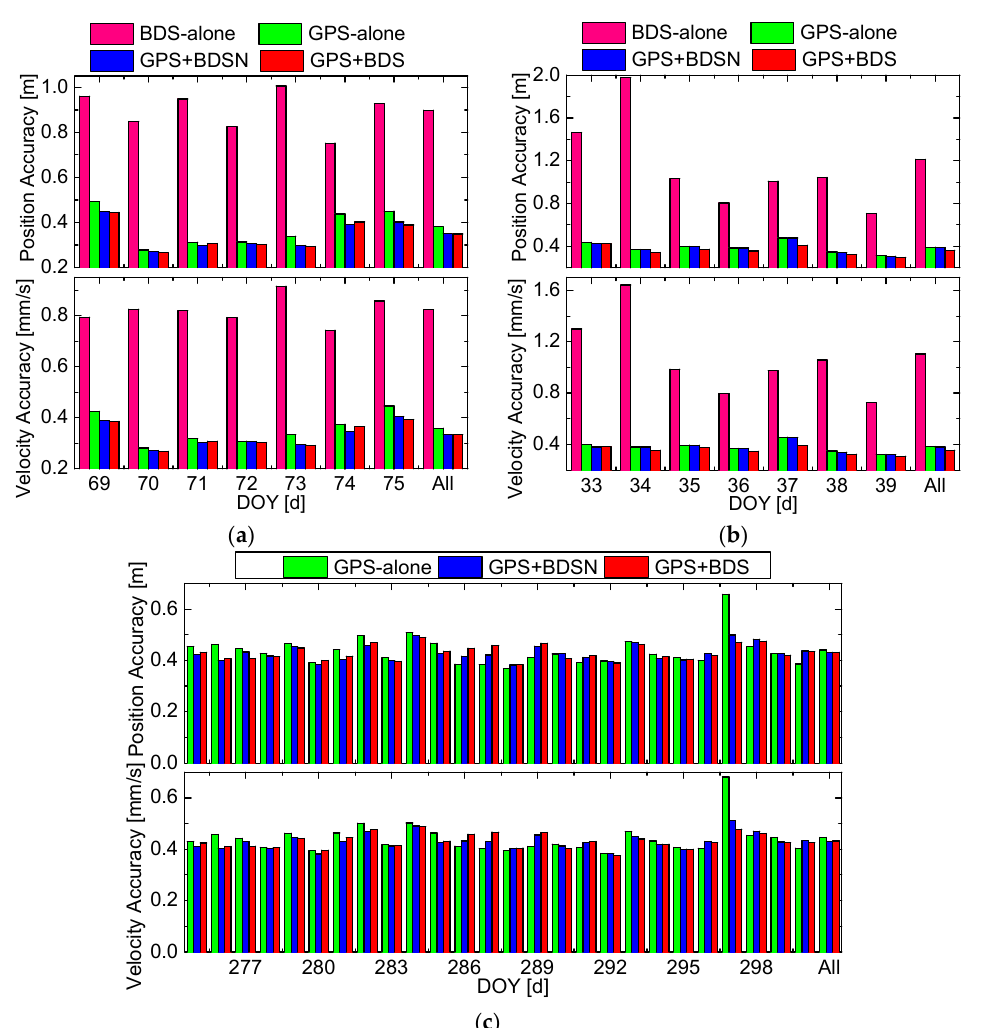
Figure 7. Orbit accuracies comparison for different GPS/BDS fusion solutions: ( a ) orbit accuracy statistics at DOY 69–75, 2015; ( b ) orbit accuracy statistics at DOY 33–38, 2018; ( c ) orbit accuracy statistics at DOY 275–300, 2013.